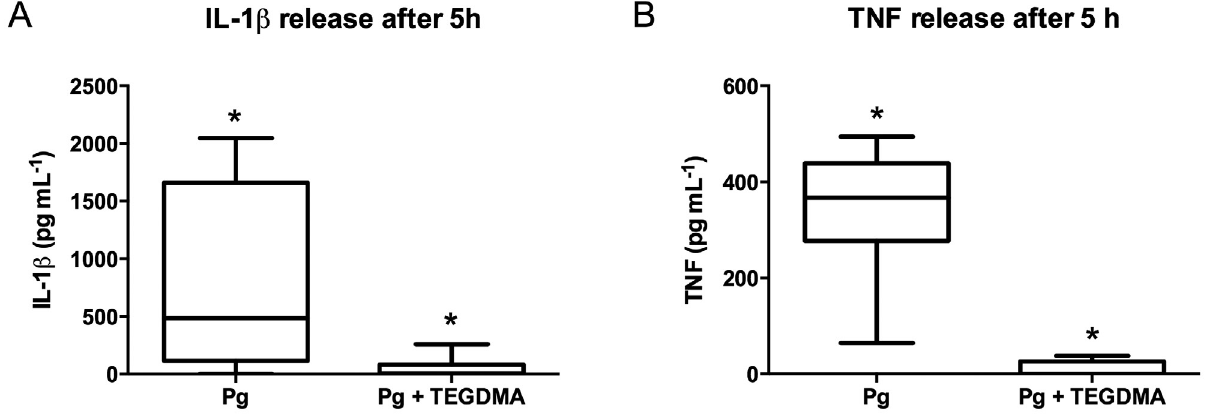
Figure 7- Effect of TEGDMA on bacterial-induced cytokine release by peripheral blood mononuclear cells (PBMC). Culture supernatants were harvested at 5 h and tested for the secretion of cytokines using ELISA analysis. Graph bars represent the median values with range. Data from 8 donors